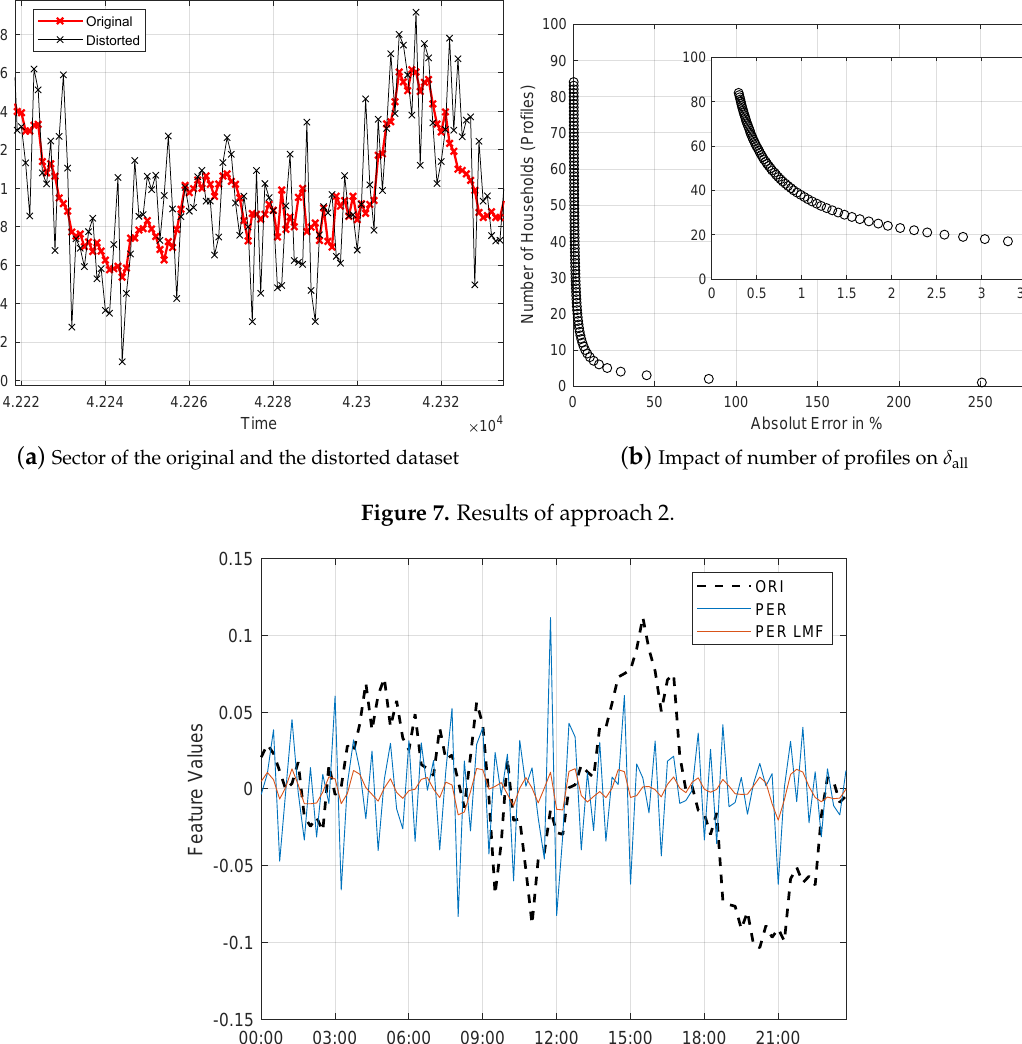
Figure 8. Feature detection of the approach 2 (mean values over one